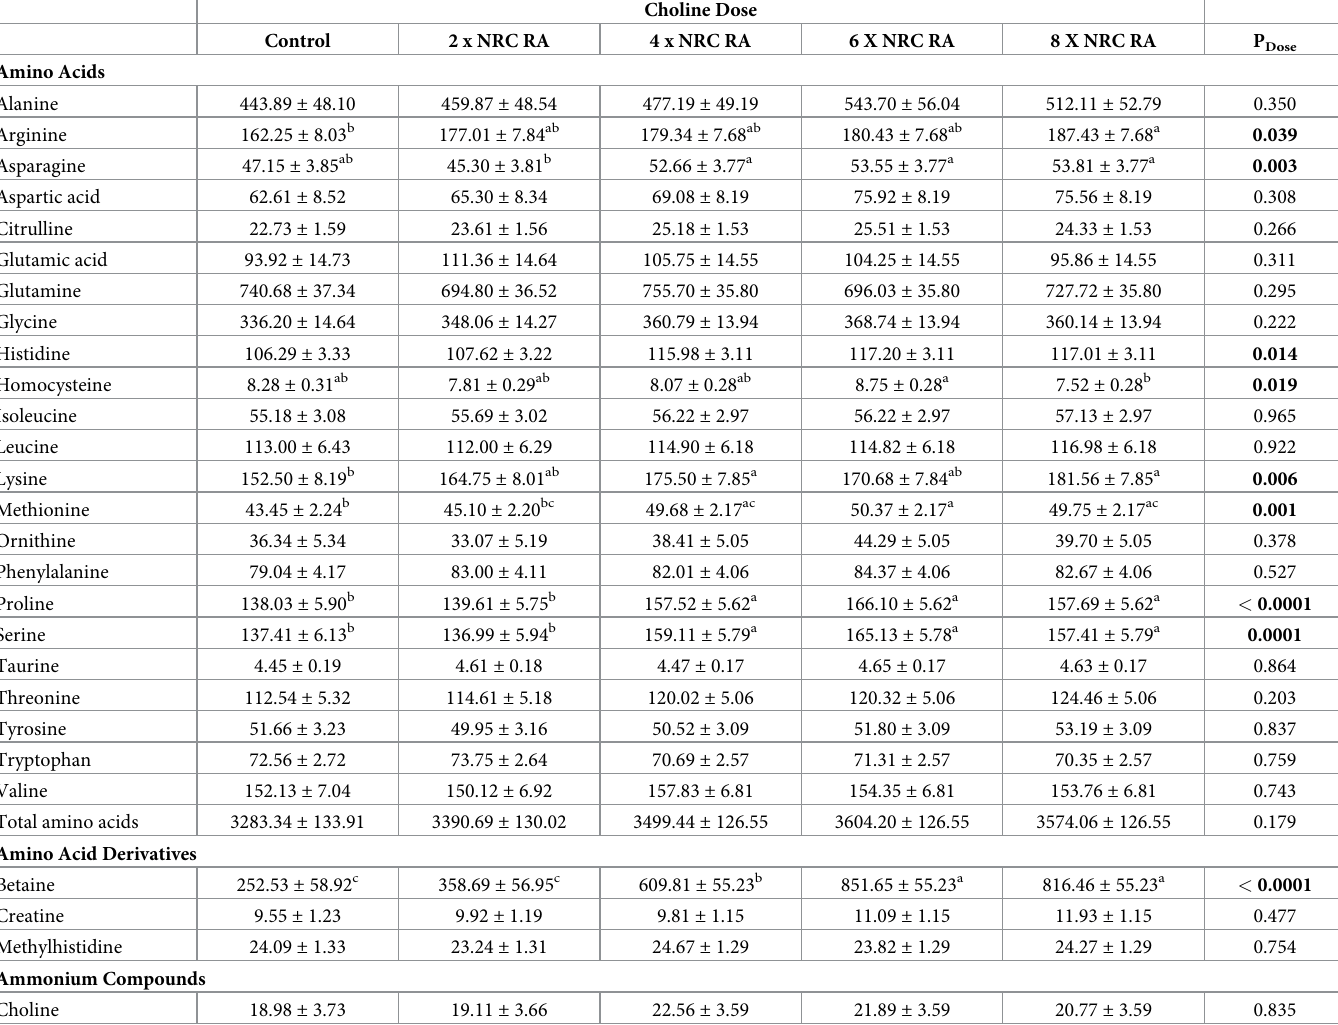
Table 3. Mean serum concentrations ( μ M) of amino acids, amino acid derivatives, and ammonium compounds determined by DI-MS in overweight cats (n = 14) receiving control (no additional choline supplementation, 1.2 x NRC RA, 77 mg/kg BW 0.67 ), choline at 2 x NRC RA (126 mg/kg BW 0.67 ), 4 x NRC RA (252